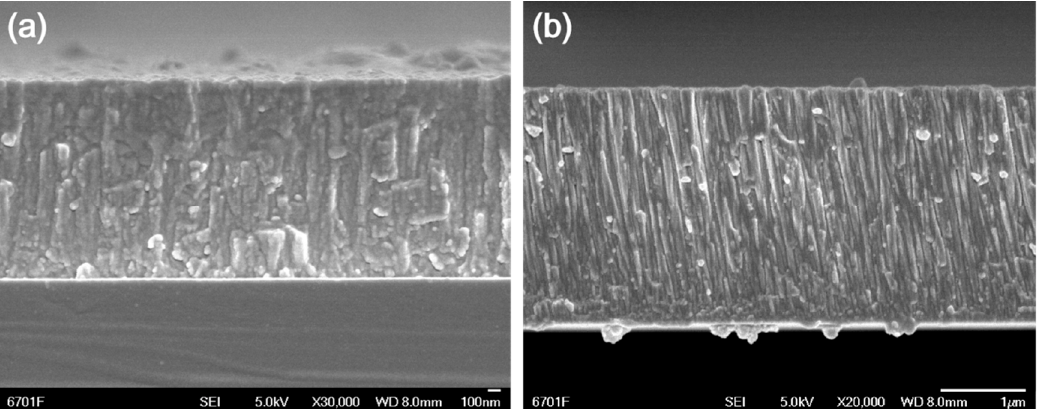
Figure 6. Microstructure comparison via high resolution SEM images: ( a ) T5 with a dense nanoparticle stacking structure and ( b ) T3 with a column stacking structure.